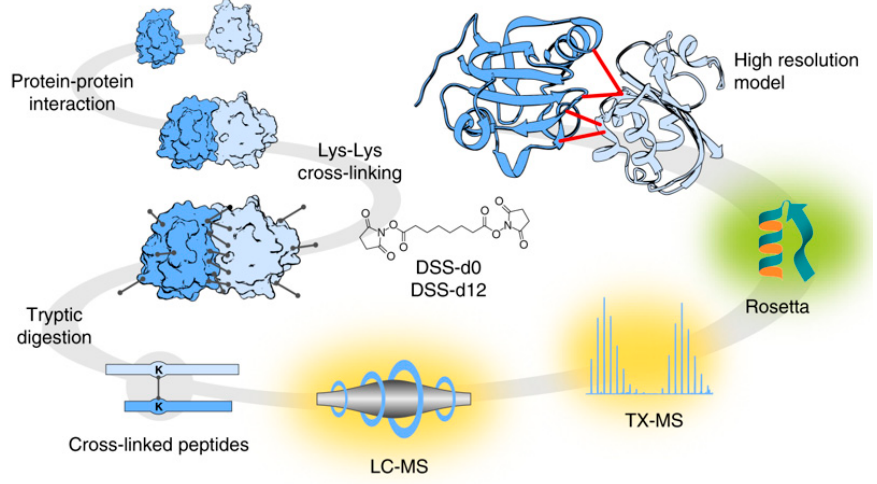
Figure 1. Targeted cross-linking procedure for targeted chemical cross-linking mass spectrometry (TX-MS). Firstly, Protein-Protein Interactions (PPIs) were chemically cross-linked with heavy/light disuccinimidyl suberate (DSS) to further digest the complex PPI cross-linkers. The digested peptide signals were targeted and extracted from Liquid Chromatography (LC)-MS data. The chemically complex cross-linked elements were subjected to MS analysis and subsequently modelled to generate tertiary structures, which were docked to produce a compendium of possible quaternary structure models. For identification of the candidate cross-linked peptides, the authors proposed the use of a guide for the molecular docking of crystal structures of the targeted proteins. This research was originally published in Nature Communications . Hauri et al. Rapid determination of quaternary protein structures in complex biological samples. Nat Commun . 2019 Jan 14; 10(1):192 © Copyright Clearance Center’s. Reprint from